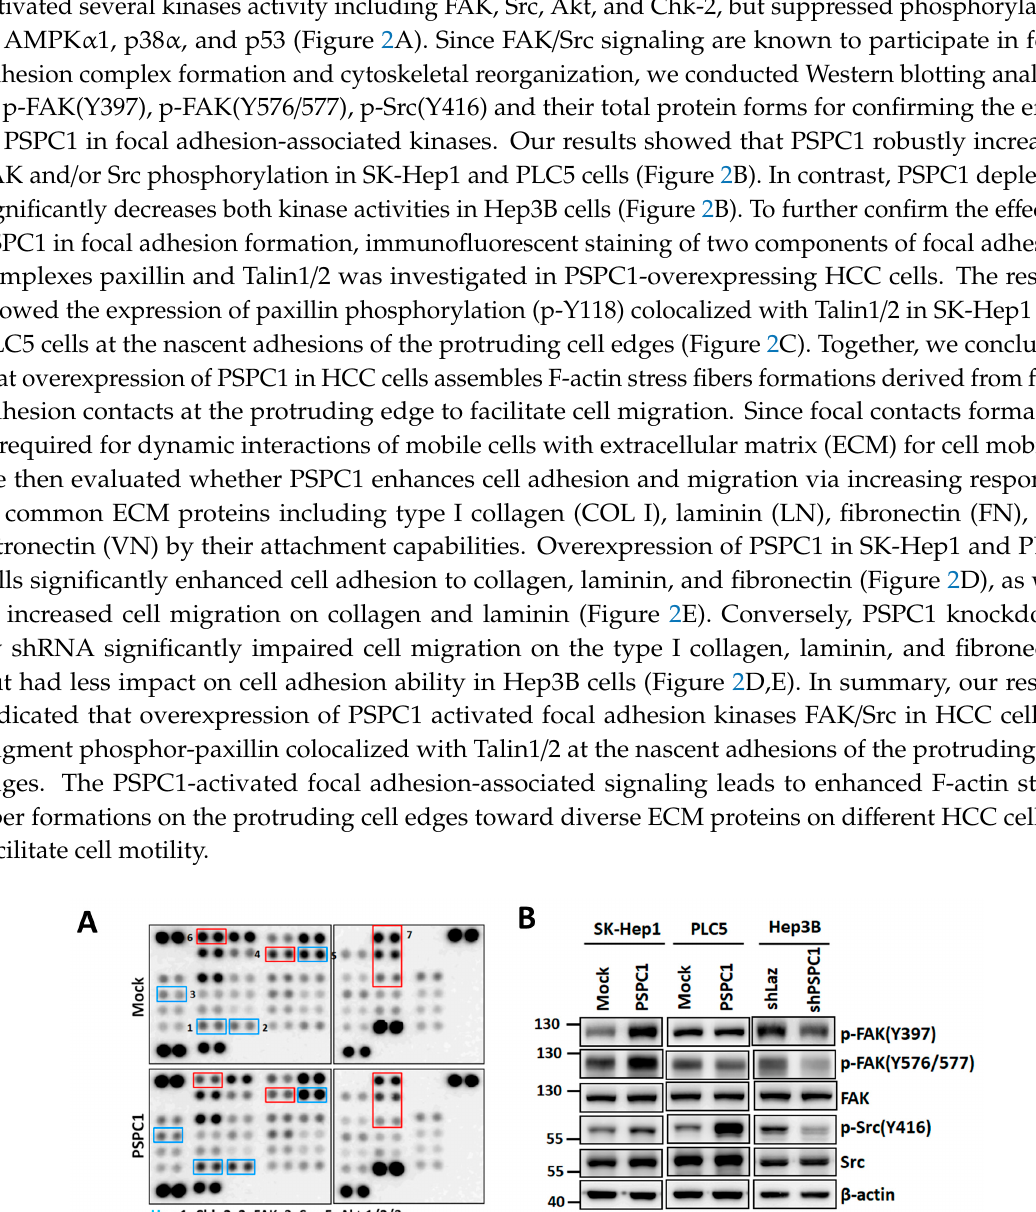
Figure 2. PSPC1 modulates FAK and Src kinases activity to promote cell adhesion and motility on extracellular matrix. ( A ) Phospho-kinase array was performed by using protein lysates of PSPC1-expressing SK-Hep1 cells. ( B ) Expression of phosphorylated FAK (Y397 and Y576/577) and Src (Y416) with their total proteins was investigated in three PSPC1-modulated HCC cells by Western blotting analysis. ( C ) Colocalization of phospho-Paxillin (green) and Talin1/2 (red) by double immunofluorescence staining in three HCC cells. Scale bars: 5 µm. ( D ) PSPC1-overexpressing and knockdown cells were seeded with serum free medium and plated into ECM coating cells of 96-well plate (COL I: collagen type I, LN: laminin, FN: fibronectin, VN: vitronectin) for 30 min. Adhered cells were counted in full field. ( E ) Capability of cell migration